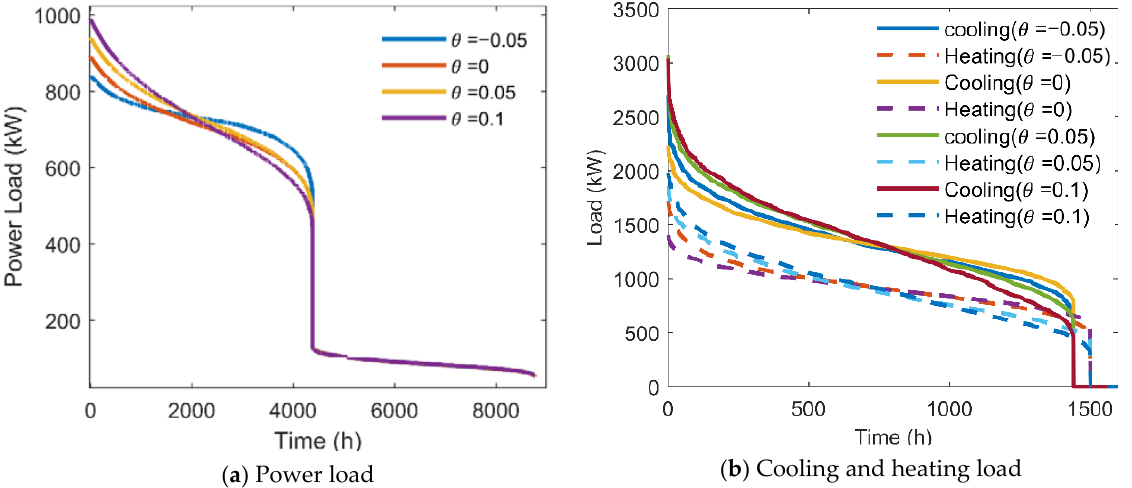
Figure 7. Delayed load curve of power load ( a ), and cooling and heating load ( b ) at the θ of –0.05, 0, 0.05, and 0.1.